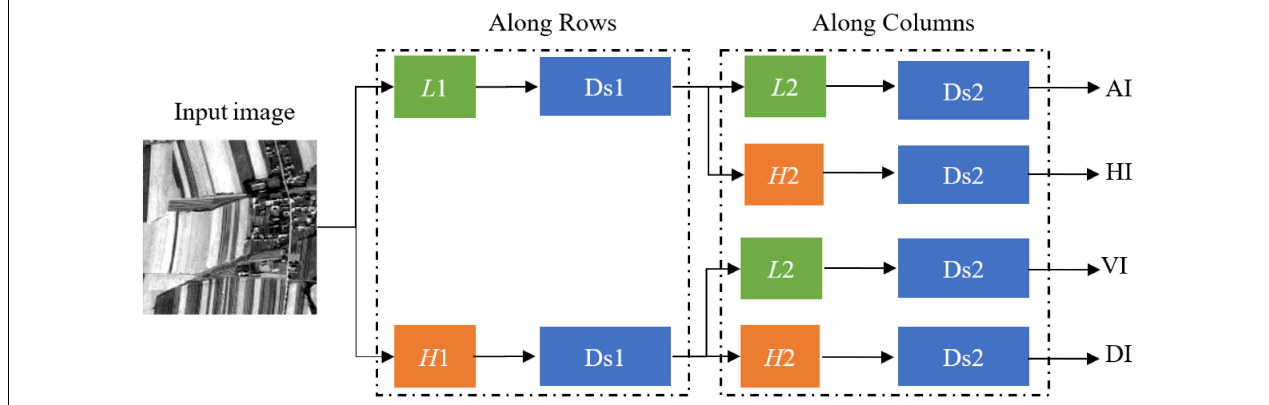
FIGURE 5 | Decomposition procedure of the multi-scale image. L 1 is the first low-pass filter. L 2 is the second low-pass filter. H 1 is the first high-pass filter. H 2 is the second high-pass filter. Ds1 is the first down sampling. Ds2 is the second down sampling. AI is an approximation sub-image. HI is a horizontal detail sub-image. VI is a vertical detail sub-image. DI is a diagonal detail sub-image.